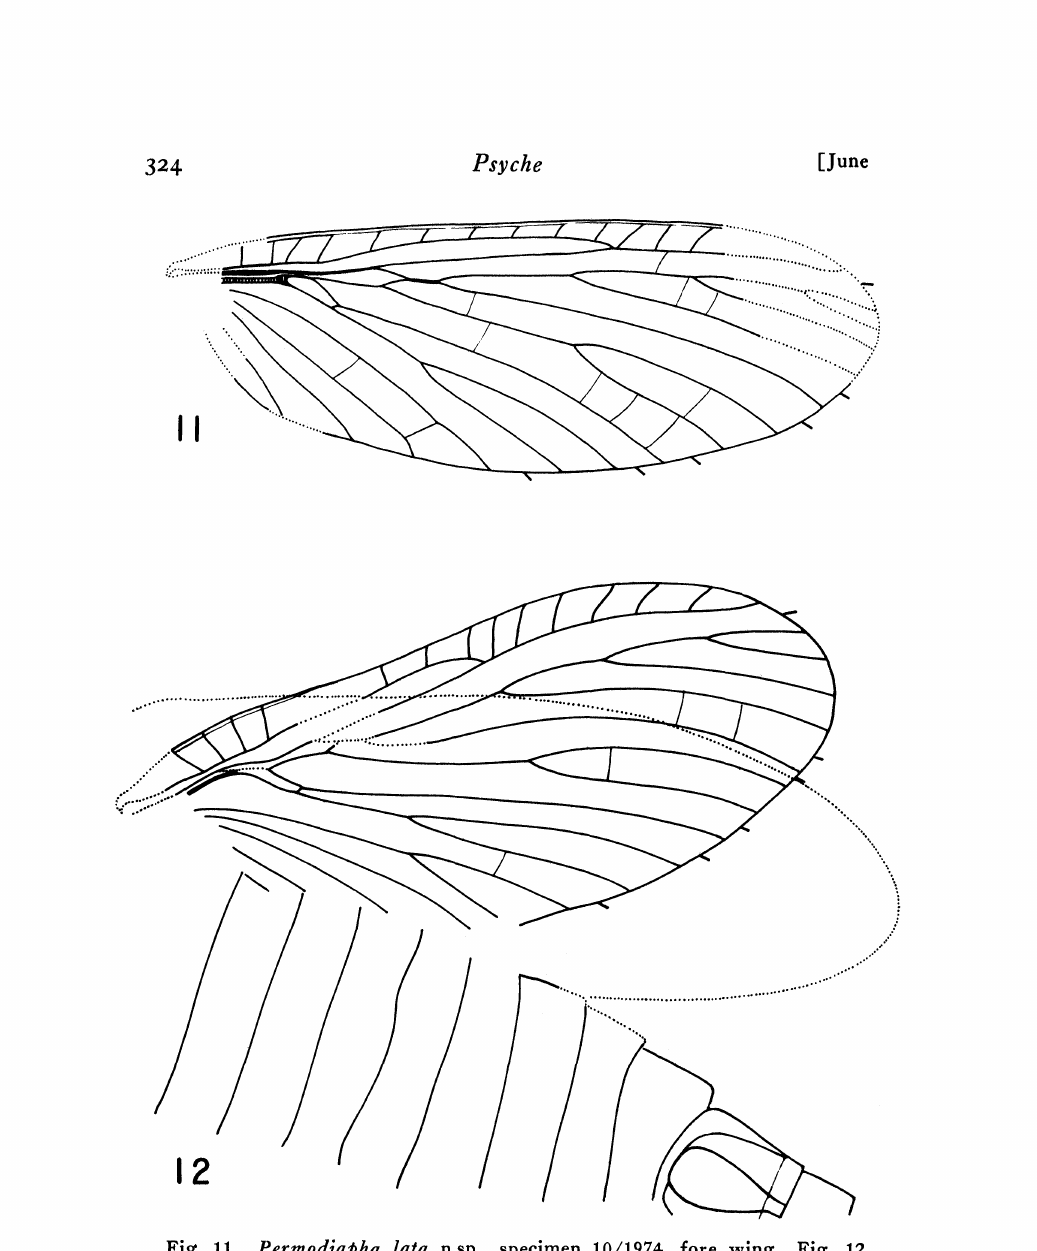
Fig. 11. Permodialha lata n.sp., specimen 10/1974, fore wing. Fig. 12. Permodiaha lata n.sp., specimen 9/1974. Hind wing, fore wing outlined.